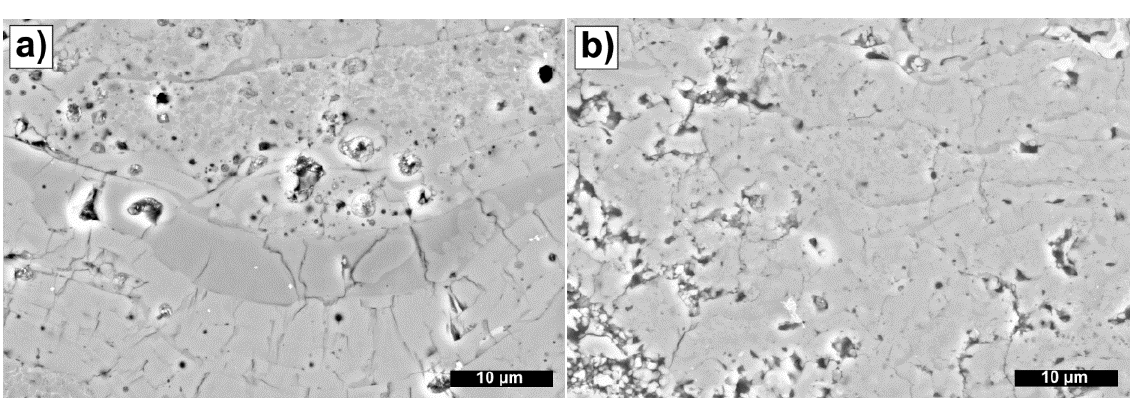
Figure 7. Structural details: ( a ) Partially molten area in APS_AT2 coating; and ( b ) partially molten and unmolten areas in the HVOF_AT2 coating. FE-SEM images.